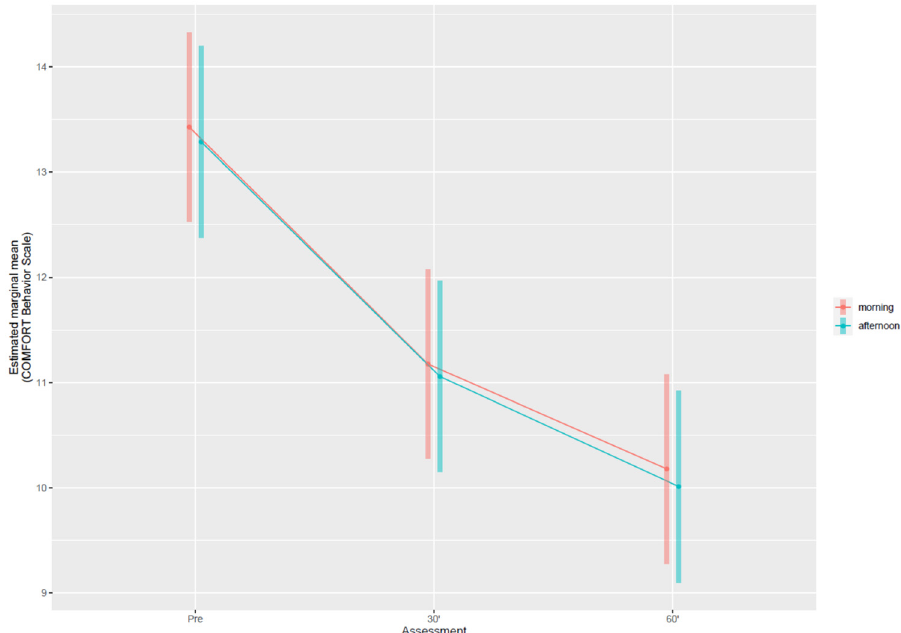
Figure 1. Mean variation of the COMFORT-Behavior Scale through assessment times (pre intervention, after 30 and 60 min), stratified by the moment of the day in which it occurred. Vertical bars denote 95% Confidence Interval.